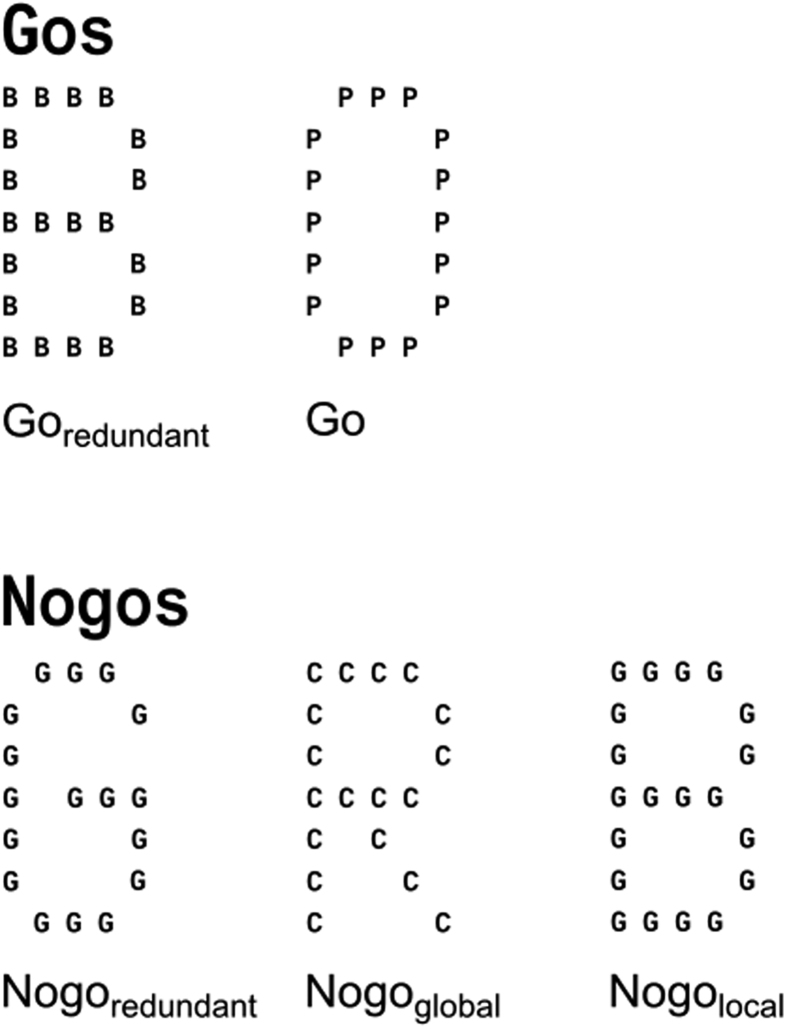
Stimulus material employed in the task.Upper row: examples for Goredundant and Go stimuli. Lower row: Examples for Nogoredundant, Nogoglobal and Nogolocal stimuli.